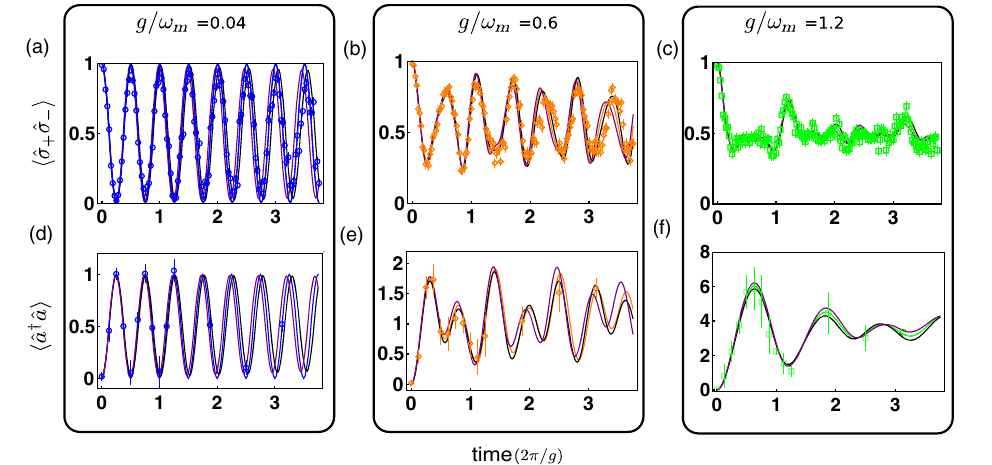
and Ω . The black b r 1 − ϵ Þ Ω 1 þ ϵ Þ Ω and Ω , respectively, setting b ¼ ð r b ¼ ð r